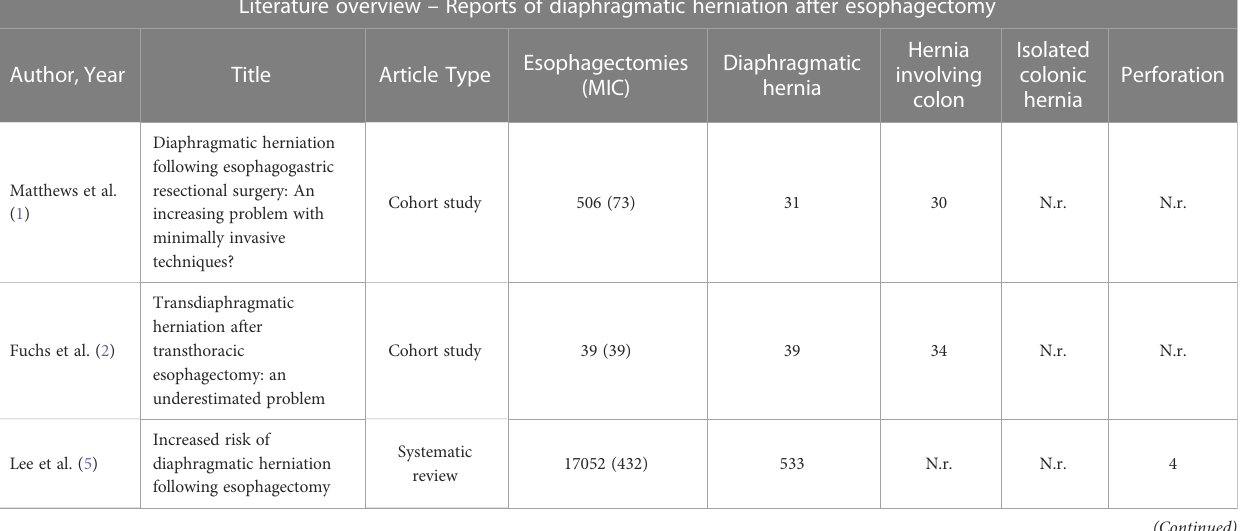
TABLE 1 Overview of the literature on transhiatal colonic herniation, with and without prior esophagectomy. Literature overview – Reports of diaphragmatic herniation after